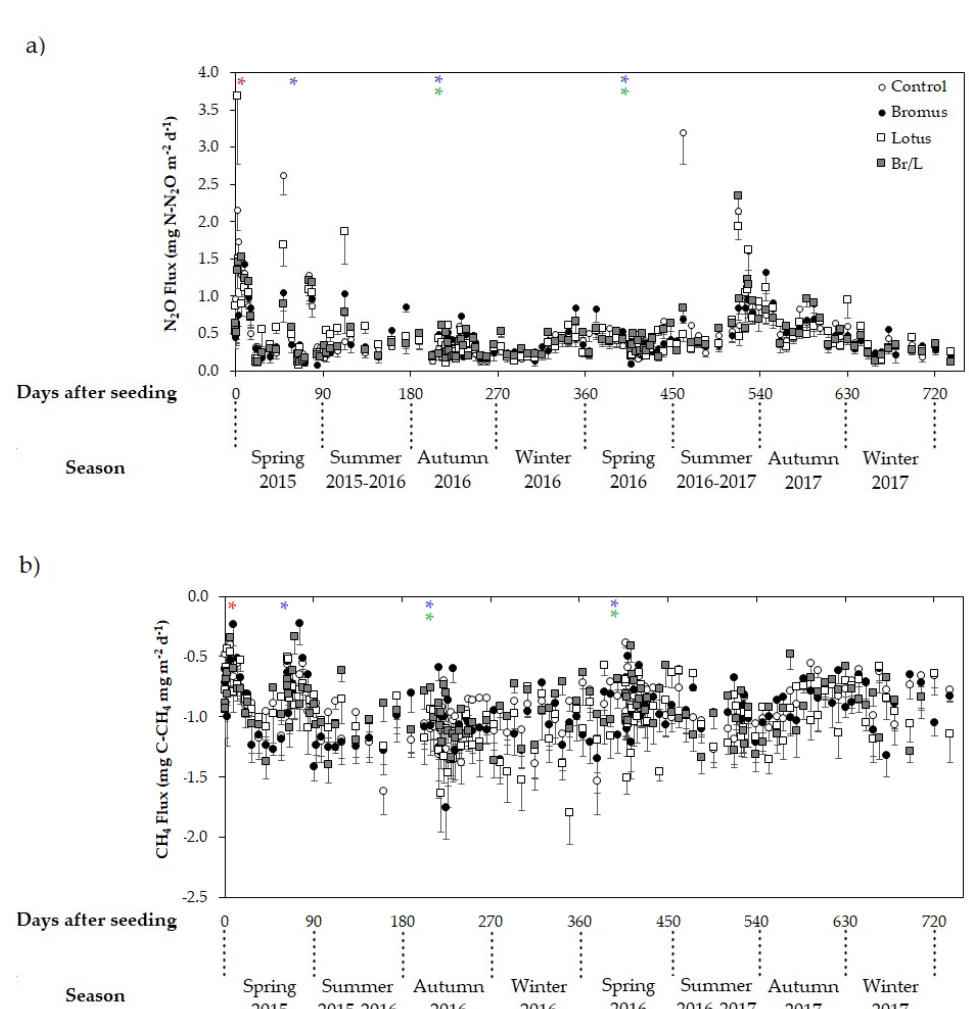
Figure 3. Daily fluxes of ( a ) N–N 2 O and ( b ) C–CH 4 for the different treatments during the experimental period (September 2015–September 2017). Original data with no interpolation ( n = 5,-standard error of the mean only). Red, blue and green asterisks indicate N application to all treatments, control treatment and to Bromus, respectively. Table 3. Effect of treatments and season on average daily fluxes of N–N 2 O, C–CH 4 and CO 2-eq during the first and second years, and overall average.